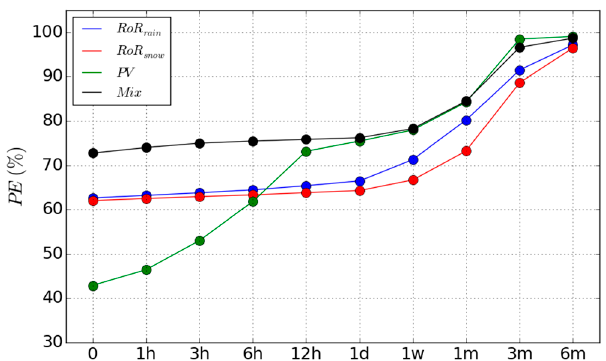
Figure 5 . Evolution of the penetration rates with the storage capacity for solar PV power (green), RoR power coming from either snowmelt dominated (red) or rain-fed (blue) catchments and for the mix defined by S PV = 0.25 and S H = 0.75 (black). Values of storage capacities are given in hours of average load; h , d and m respectively mean hour, day and month.